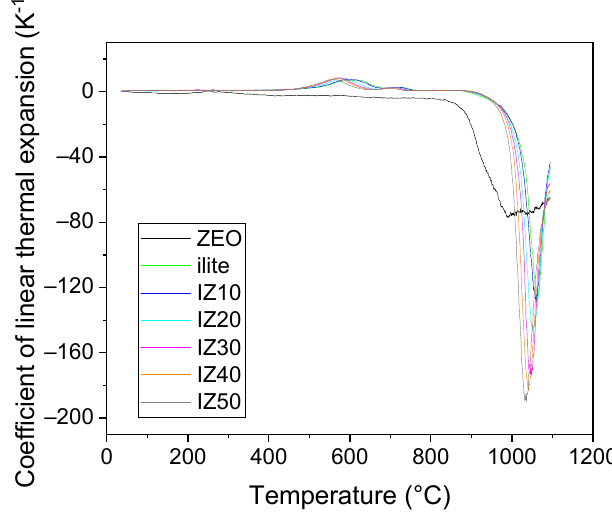
Figure 5. Coefficient of linear thermal expansion of the samples.